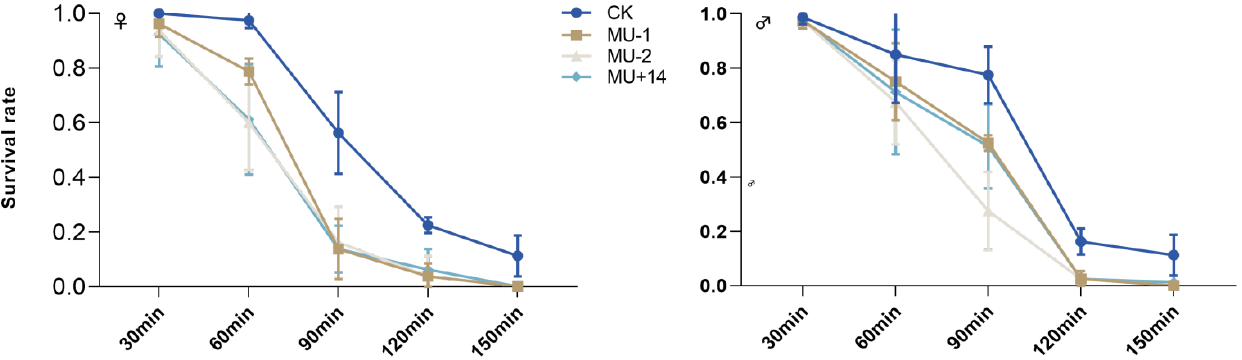
Figure 8. Effects of PxTret1-like knockout on the survival of adults exposed to extreme temperatures for different times. Error bars represent standard error of the mean. Data represent 20 female adults or male adults per repetition and each replication was repeated four times.